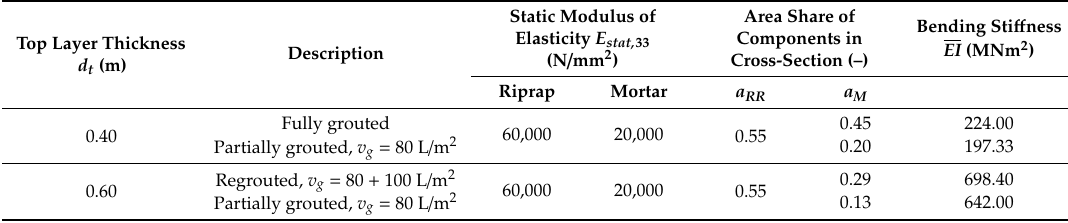
Table 4. Parameter for MGRR in the PEF model.